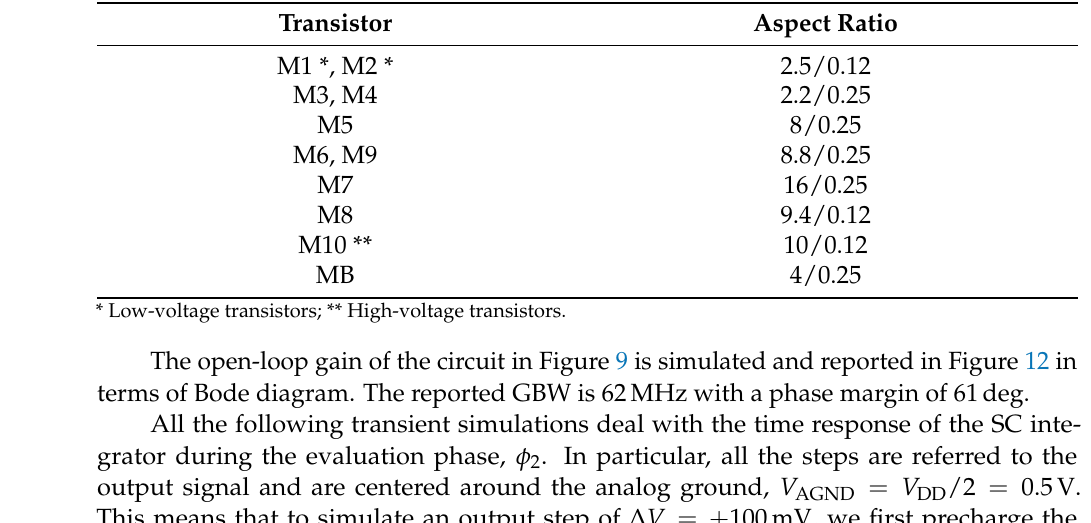
Table 3. Transistors’ aspect ratios for the RNMC-ICBFF